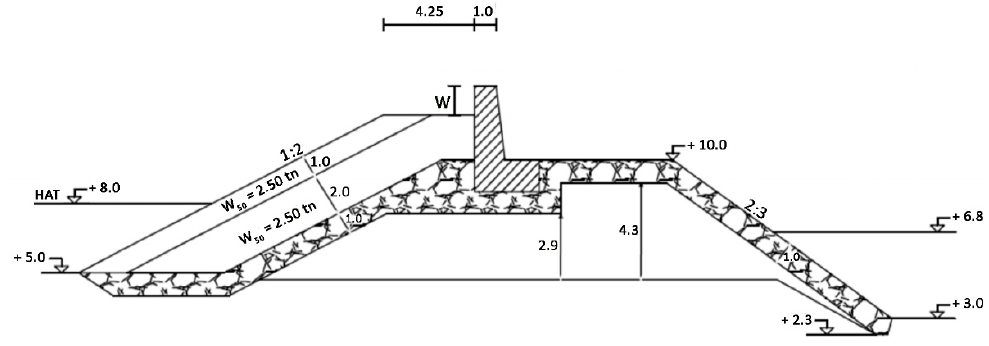
Figure 9. Cross-section of the studied rubble mound breakwater in Deauville France, for mitigation option 2.